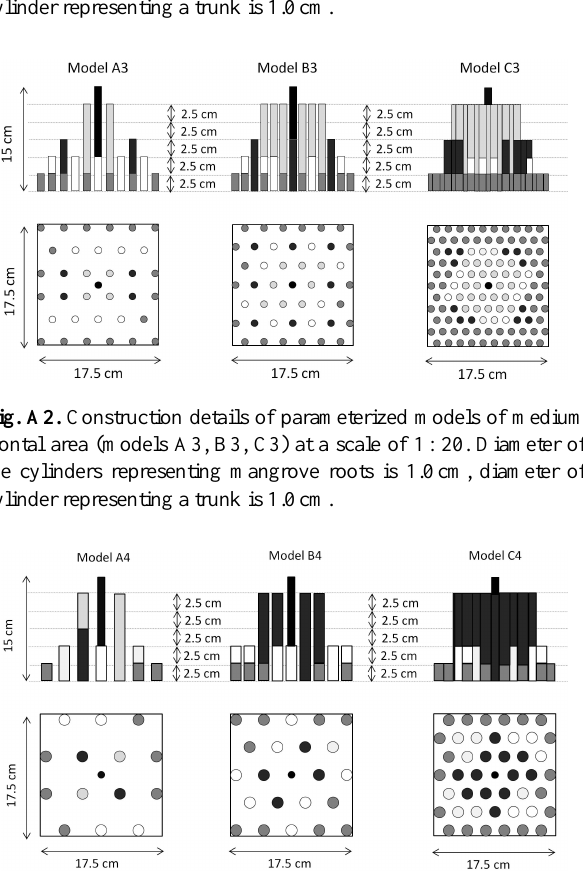
Fig. A3. Construction details of parameterized models of lowest frontal area (models A4, B4, C4) at a scale of 1 : 20. Diameter of the cylinders representing mangrove roots is 1.5cm, diameter of cylinder representing a trunk is